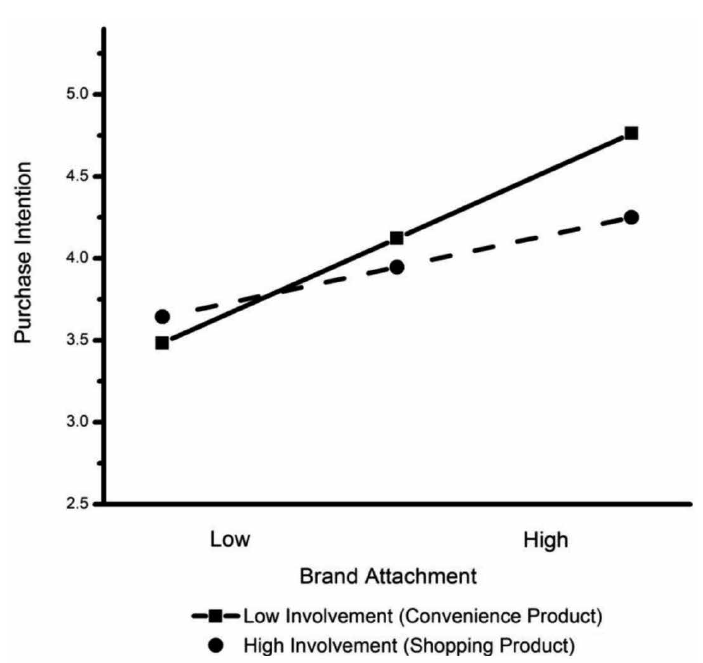
Figure 4. Two-way interaction effects of brand attachment by product involvement on purchase